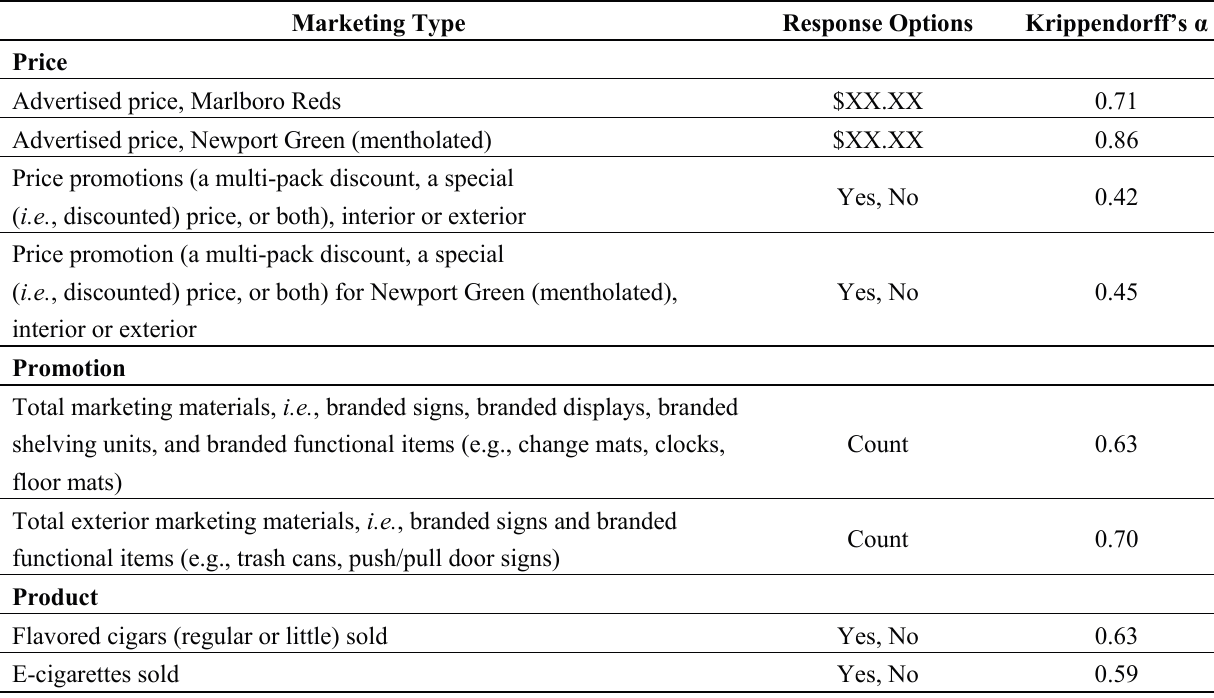
Table 1. Dependent variables by domain of marketing and inter-rater